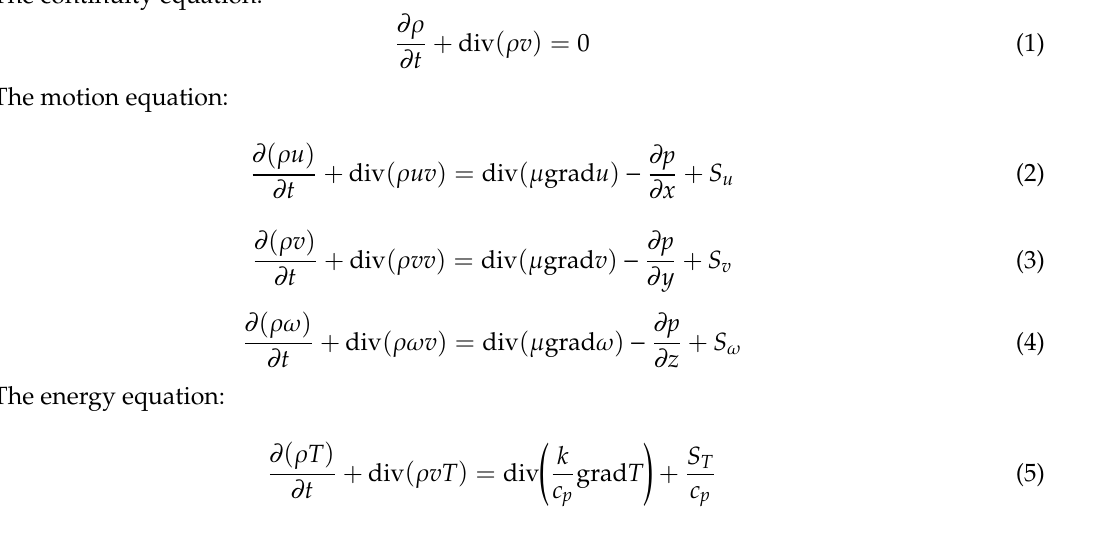
Figure 4. Mesh of the computational domain.